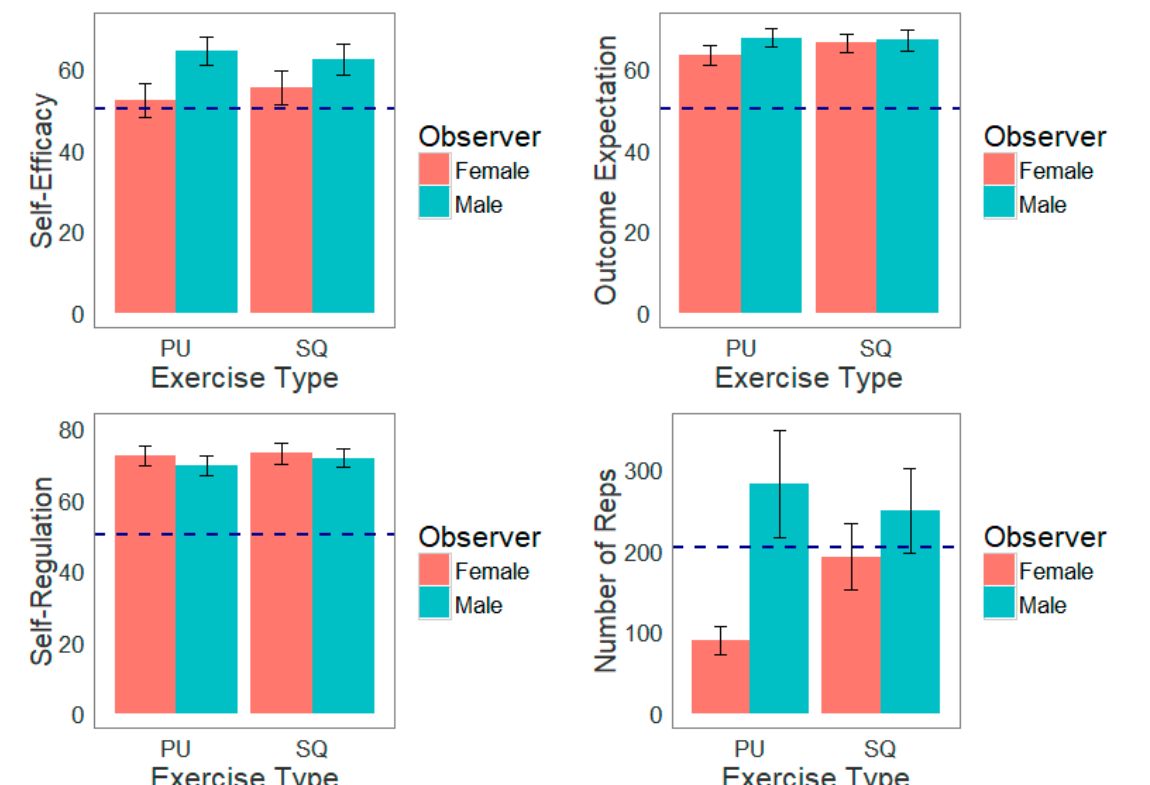
Figure 6. Mean rating of perceived self-efficacy, self-regulation, outcome expectation on a 0%–100% scale (bar represents neutral value), and projected exercise performance level in the number of reps per week (bar represents overall mean value).